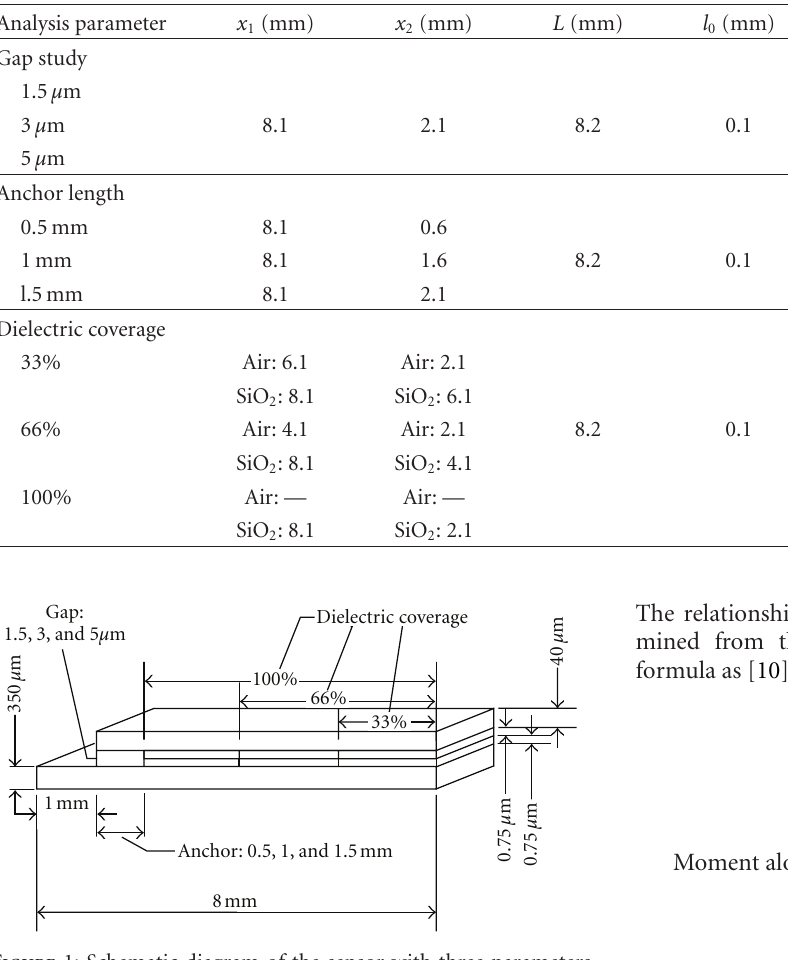
Table 3: Specific values used in the calculation for all analysis parameters.